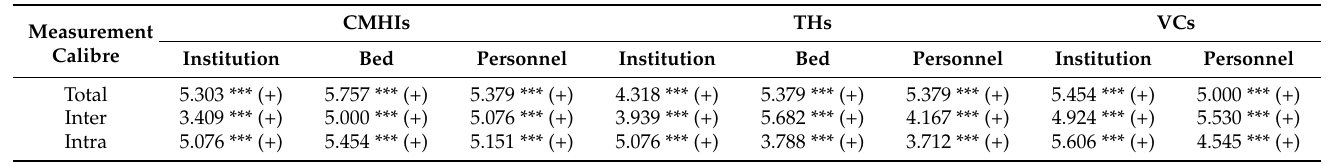
Table 3. Mann–Kendall test results of the Theil index (CMHIs: county and county-level city medical and health institutions; THs: township hospitals; VCs: village clinics). CMHIs THs VCs Measurement Calibre